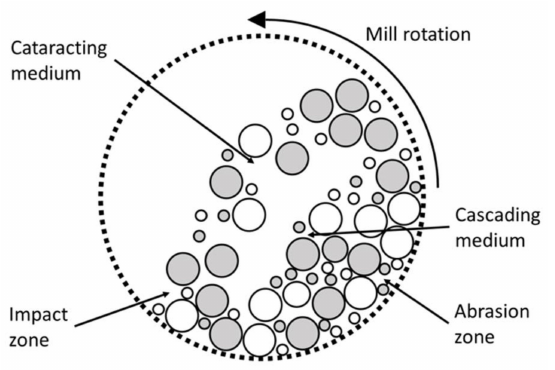
Figure 2. Aggregate motion in a tumbling mill (adapted from Ali et al., 2019 [28]; Wills 2016 [29]; Wills and Finch 2015 [27]).